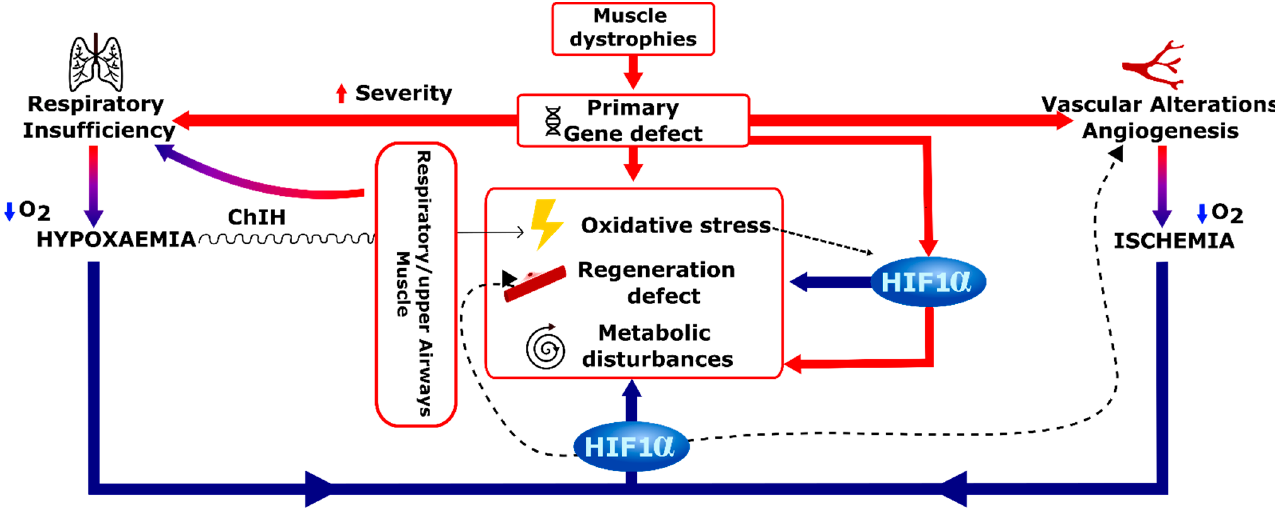
Figure 6. Overview of causes and consequences of hypoxia and HIF-1 α activation in the context of MDs. The activation of hypoxic response pathways could emerge as a consequence of the primary genetic defect, or via the induction of hypoxia stress response pathways as a result of an indirect mechanisms e.g., respiratory insufficiency (inducing hypoxemia) and vascular alteration (causing ischemia).